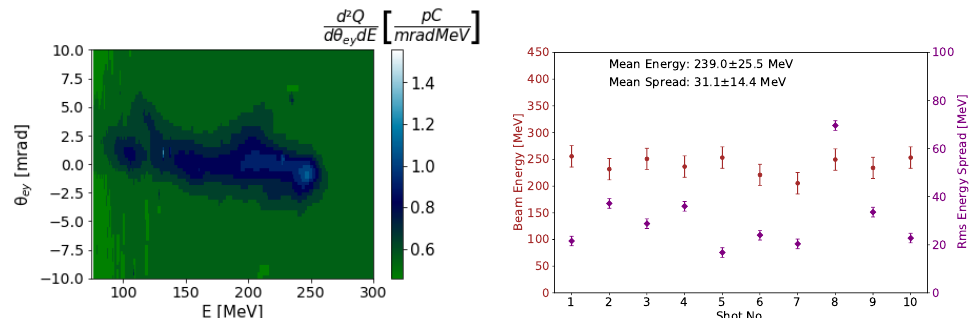
Figure 7. ( Left ): Example of electron beam energy spectrum on the diagnostic scintillator placed after the bending magnet, plotted in vertical-divergence/MeV units ( Right ): shot-to-shot fluctuation of the beam energy and rms energy spread; the uncertainty is determined by standard deviation of the